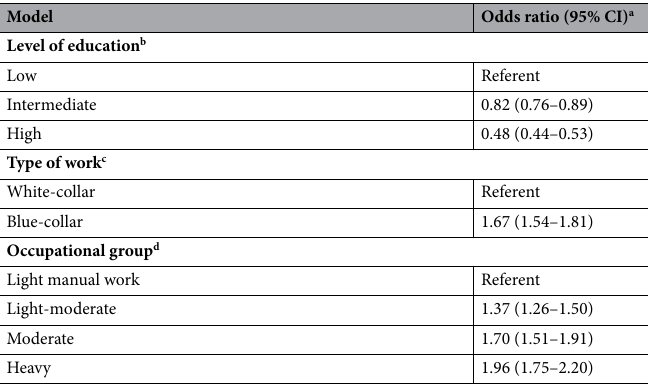
Table 2. Association between level of education and type of work and carpal tunnel syndrome. a Odds ratios with 95% confidence intervals from conditional logistic regression models; age and sex did not vary within matched sets and thus adjusted for by design and use of conditional regression. b Estimating the effect of education (model does not include type of work or occupational group). c Estimating the effect of type of work (white-collar/blue-collar) adjusted for education (model does not include occupational group variable). d Estimating the effect of occupational group (light/light-moderate/moderate/heavy) adjusted for education (model does not include type of work